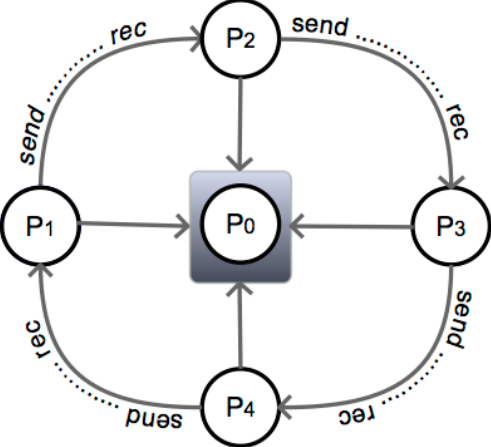
Figure 1. Provided a parallel machine of p processors, p − 1 pro- cesses are initialized and assigned with equal blocks of time series, each block’s set of time series are correlated, then these blocks are exchanged (p − 1 )/ 2 times (half round of the ring) between pro- cesses to complete the all-to-all correlations between the whole set of time series. Conversely, p 0 (the master computing element) is initialized as a master process to gather the resulting calculations and perform the analysis tasks on the resulted